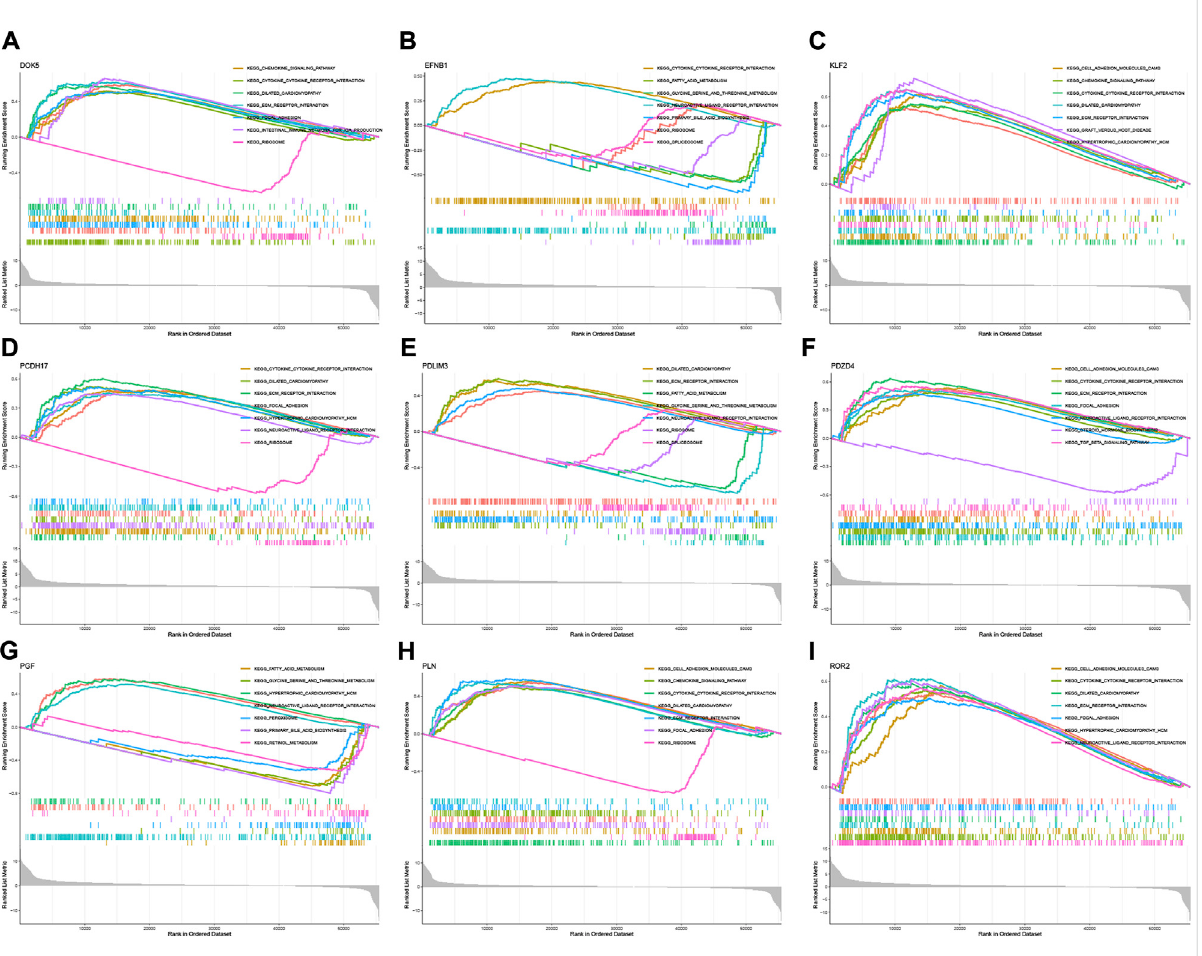
FIGURE 6 GSEA for samples with high and low expression of 9 central genes. (A) Enriched gene set collected in KEGG for samples with high DOK5 expression. (B) Enriched gene set collected in KEGG for samples with high EFNB1 expression. (C) Enriched gene set collected in KEGG for samples with high KLF2 expression. (D) Enriched gene set collected in KEGG for samples with high PCDH17 expression. (E) Enriched gene set collected in KEGGforsampleswithhigh PDLIM3 expression. (F) Enrichedgenesetcollected inKEGGforsampleswithhigh PDZD4 expression. (G) Enriched genesetcollectedinKEGGforsampleswithhigh PGF expression. (H) EnrichedgenesetintheKEGGcollectionforsampleswithhigh PLN expression. (I) Enriched gene set in the KEGG collection for samples with high ROR2